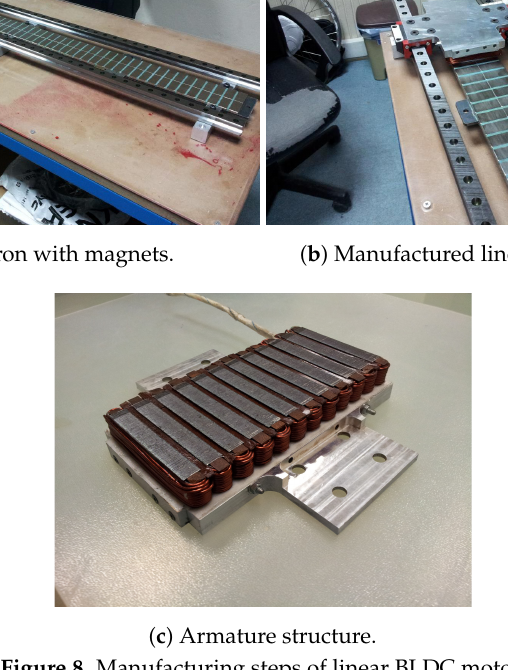
Figure 8. Manufacturing steps of linear BLDC motor.